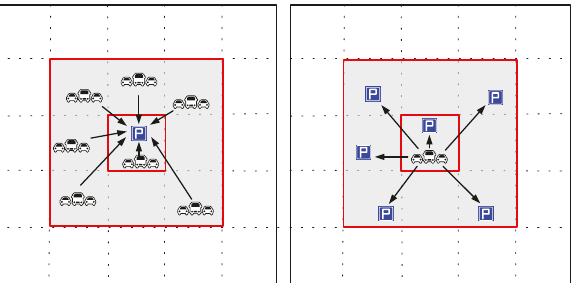
Figure 3: Sets of grids, G